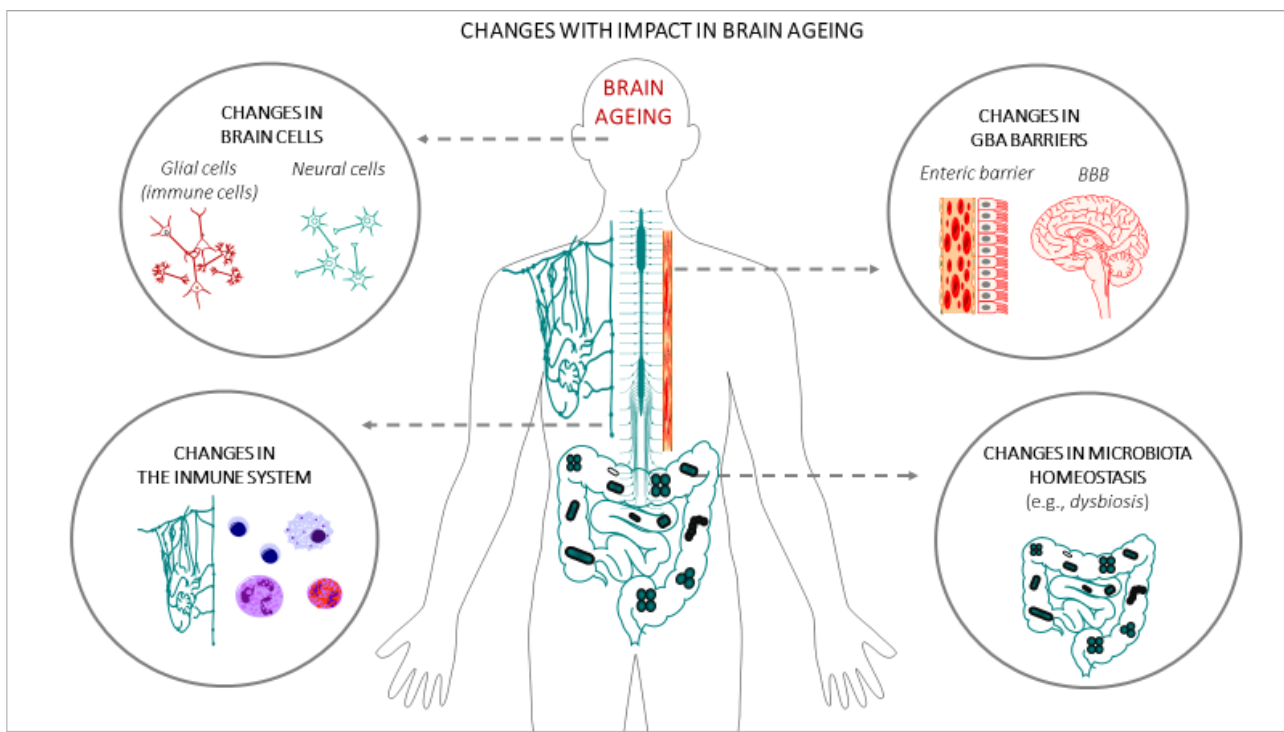
Figure 2. Changes in body systems with an impact on brain